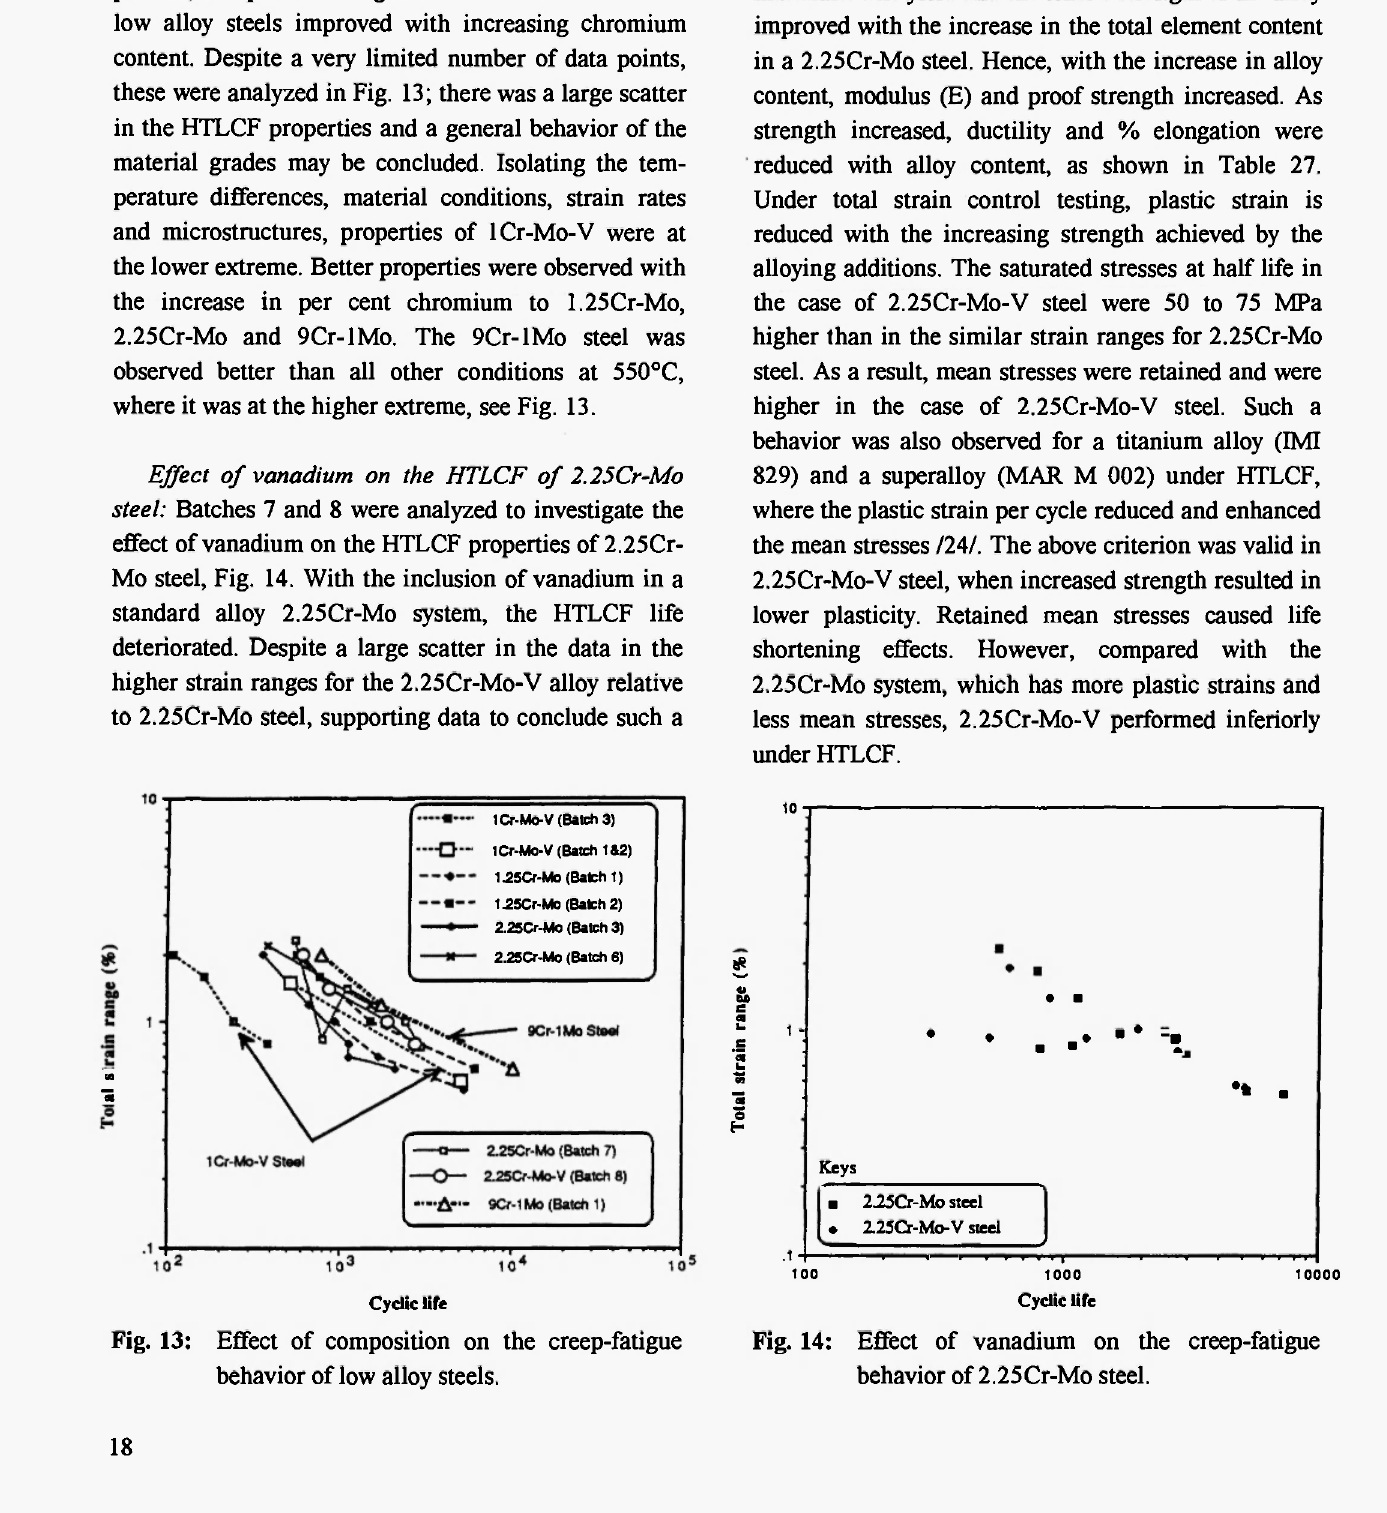
Fig. 14: Effect of vanadium on the creep-fatigue behavior of 2.25Cr-Mo